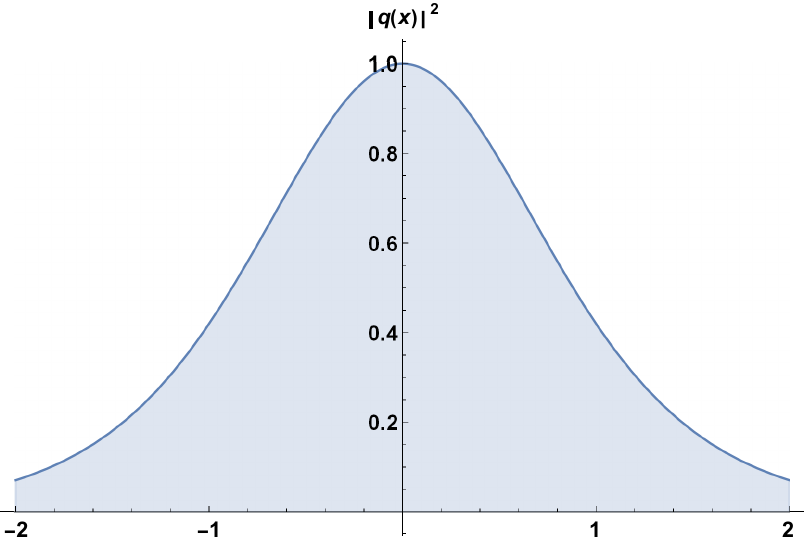
Figure 2. Profile of quiescent bright optical soliton in polarization controlled